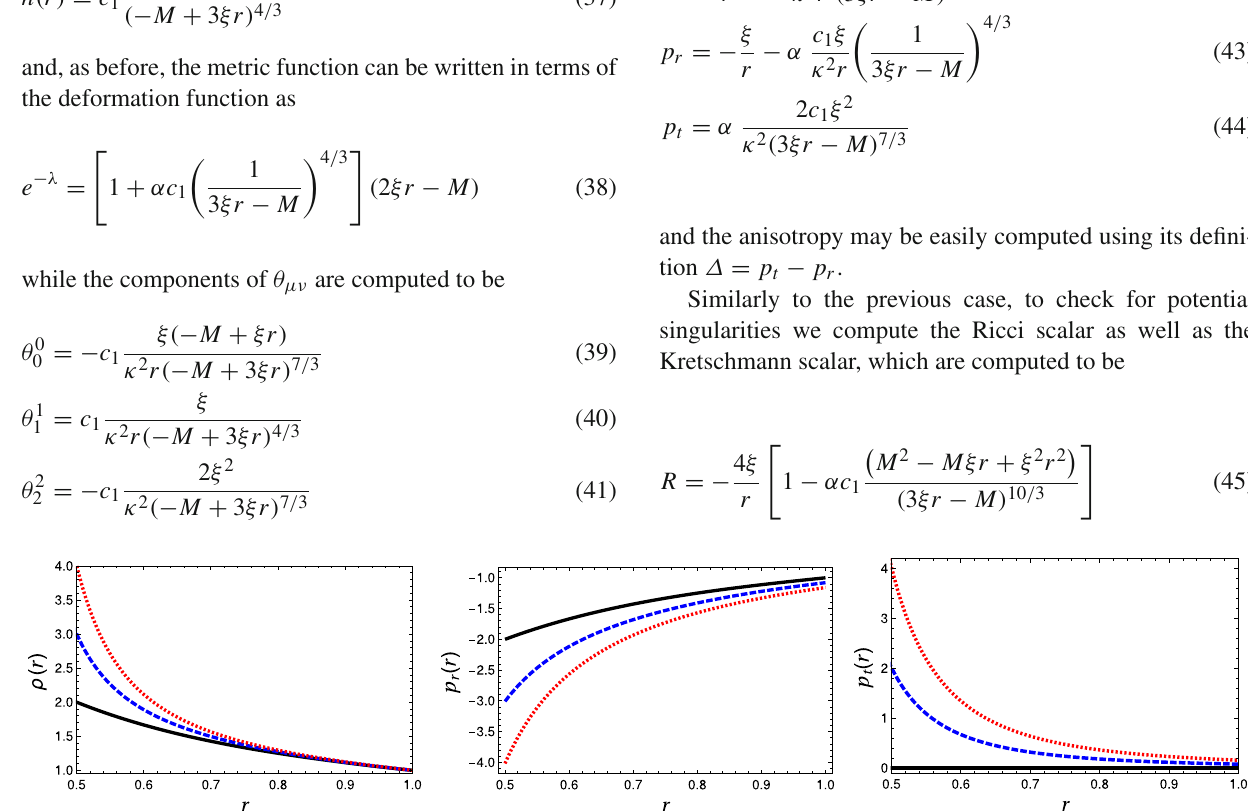
α . Right panel: Tangential pressure p t vs radial coordinate r for differ- ent values of the parameter α . Shown are: (i) α = 0 (solid black line), (ii) α = 0 . 2 (dashed blue line) and, (iii) α = 0 . 4 (dotted red line). The other two parameters have been taken equal to unity, M = ξ = 1